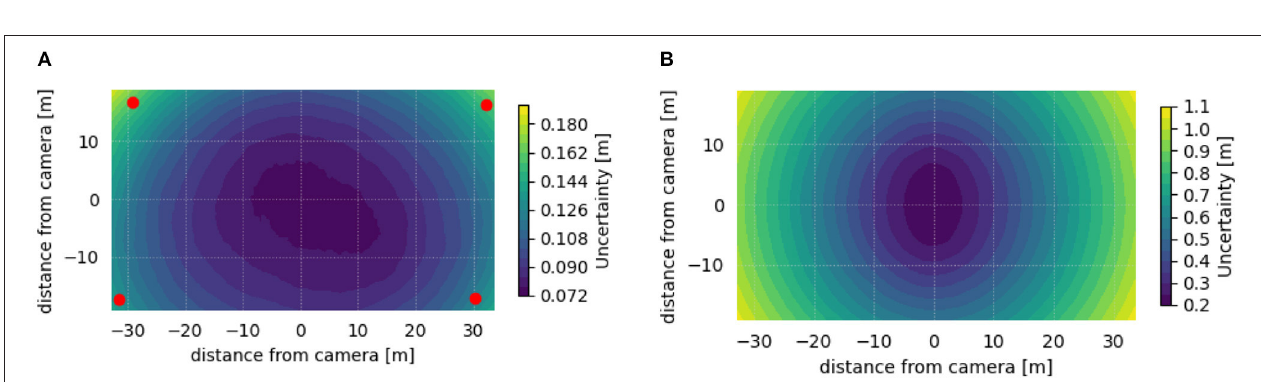
FIGURE 3 | Contours of the 95th percentile of spatial uncertainty estimated at each pixel footprint in a nadir view camera setup, after correcting the images for radial distortion. (A) Using 4 GCPs located near the corners of the FOV (red dots). (B) Using direct georeferencing.